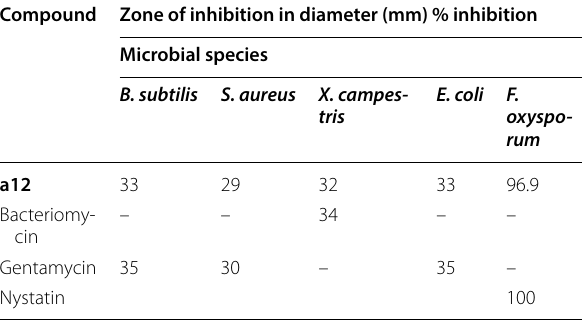
Table 7 In vitro antibacterial and antifungal activities of compound a12 Compound Zone of inhibition in diameter (mm) % inhibition Microbial species